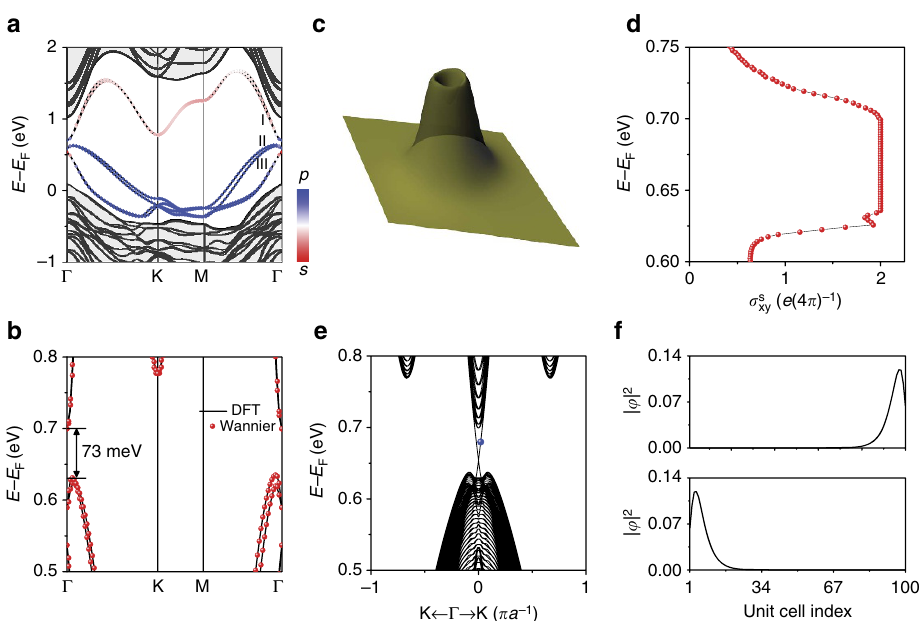
Figure 4 | Non-trivial topological phase for Au/GaAs(111) with SOC. ( a ) Band structure of Au/GaAs(111) superlattice with SOC. The red and blue colours indicate the component of s and p orbitals, respectively. ( b ) Zoom-in comparison between density functional theory (DFT) bands (solid lines) and MLWFs fitted bands (red dots) around the SOC bandgap. ( c ) Spin Berry curvature around the G point by setting the Fermi level within the energy window of SOC gap. ( d ) Spin Hall conductance as a function of Fermi level, showing quantized value within the energy window of SOC gap. ( e ) 1D ribbon band structure, showing gapless Dirac edge states within the energy window of SOC gap. ( f ) Real space distribution of the Dirac edge states at the energy marked by a blue dot in e . The two degenerate edge states are localized at opposite (left and right) edge of the ribbon.